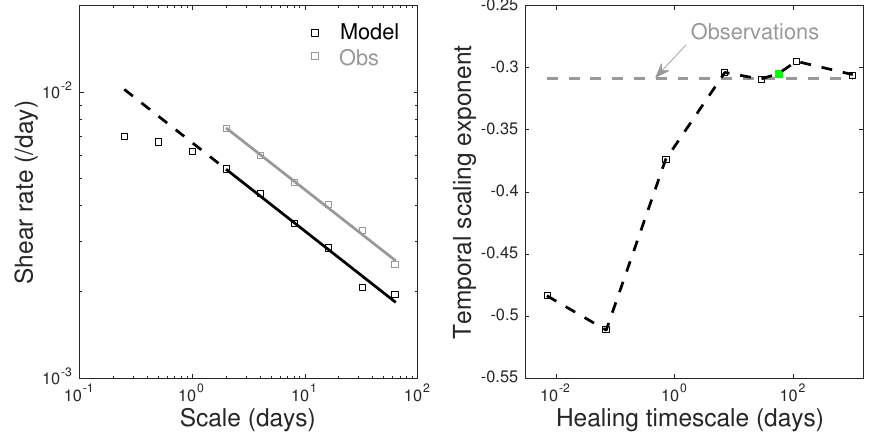
Figure 12. Temporal scaling analysis of sea ice deformation performed for the period January–May. Left panel shows the mean deformation rate (i.e., the 1 st order moment of the distribution) computed for temporal scales ranging from 6h to 60days. The deformation rate is here defined as in Rampal et al. (2008). A power-law fit (cid:104)˙ (cid:15) q (cid:105) ∼ T − α(q) is calculated for the data sets for each moment order q ranging from 0.5 to 3 (grey and black lines on the left panel for q = 1) and the scaling exponents are found to be very similar between the model and the observations. This shows the model captures the observed intermittency of sea ice deformation. The right panel shows the sensitivity of the scaling exponent for the mean ( q = 1) to the healing timescale. The green square corresponds to the exponent obtained for the reference run (shown on left